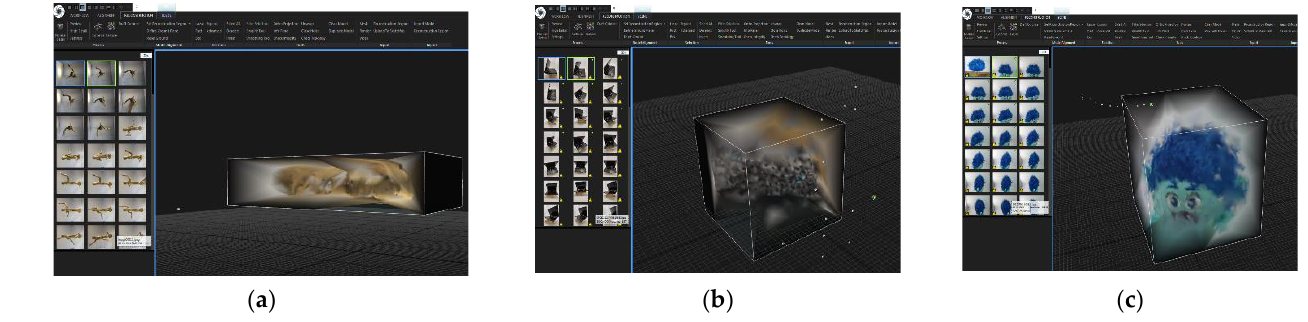
Figure 2. First attempts using a Light Box: ( a ) Wooden dummy; ( b ) laptop; ( c ) plush toy.